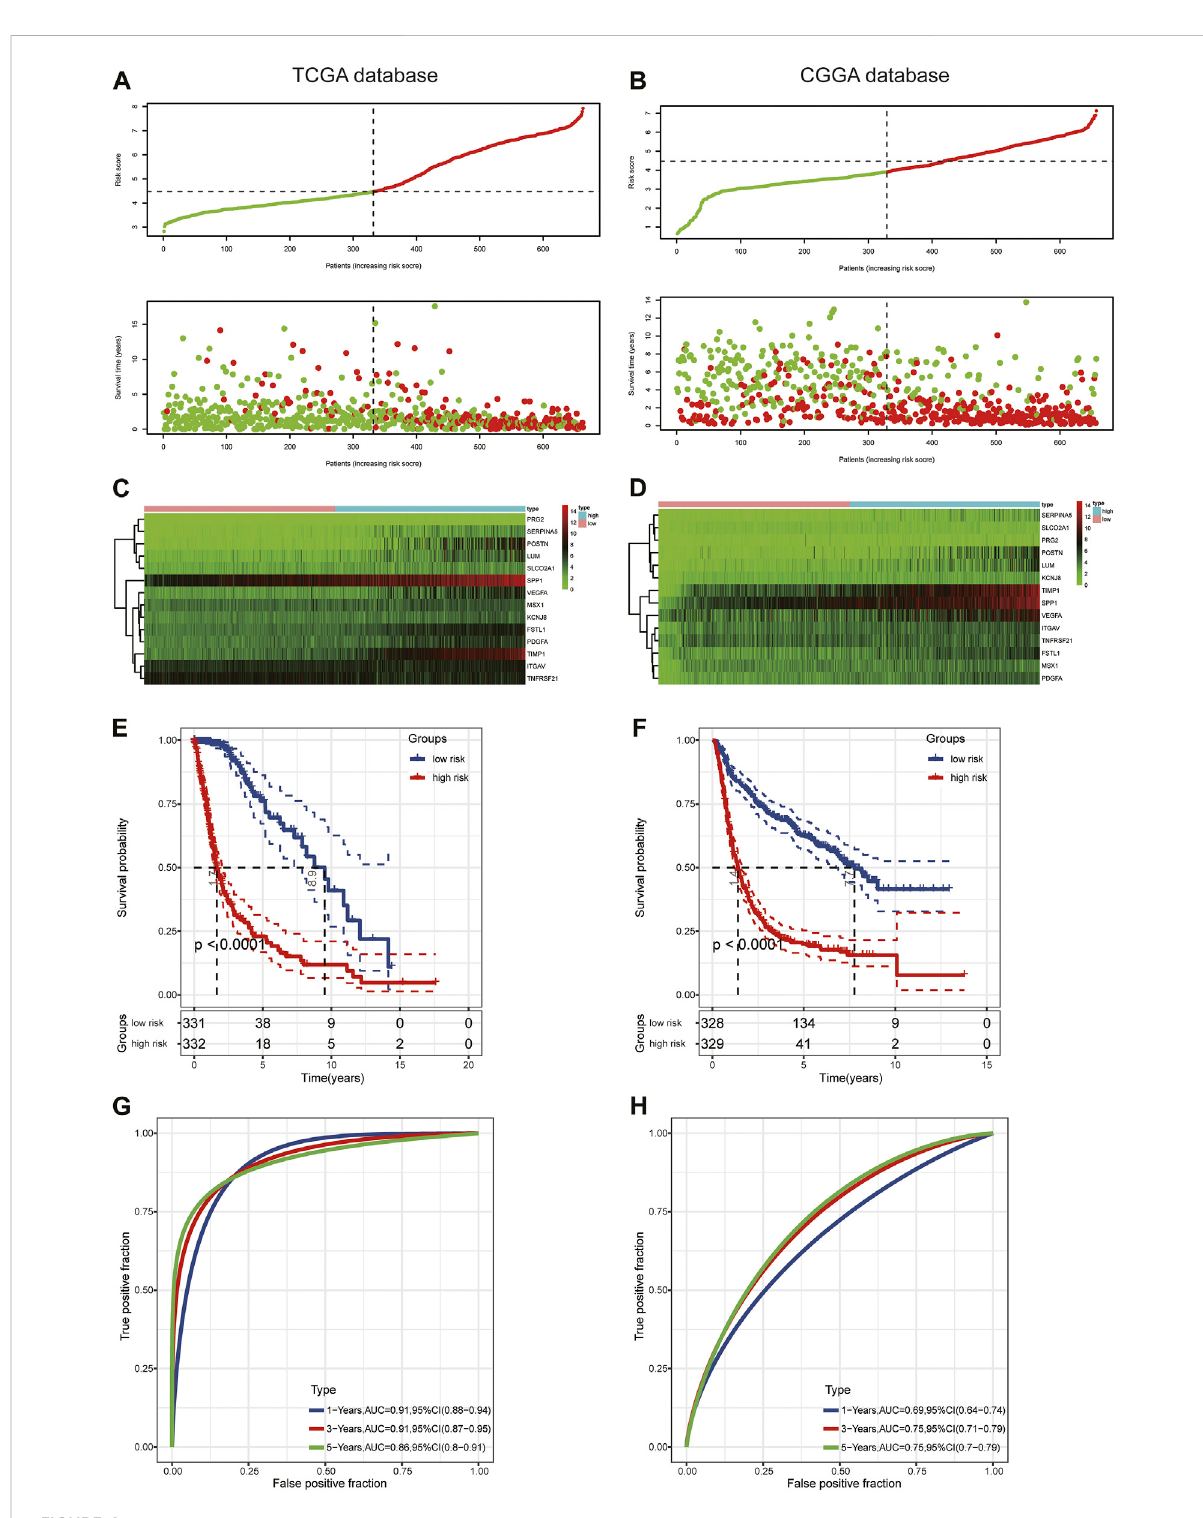
FIGURE 4 Prognostic value of the risk score in TCGA and CGGA. (A,B) Distribution of risk score and survival status. (C,D) Expression pattern of 14 ARGs in the high- and low-risk groups. (E,F) KM analysis of the risk model. (G,H) Time-dependent ROC curve analysis of the risk